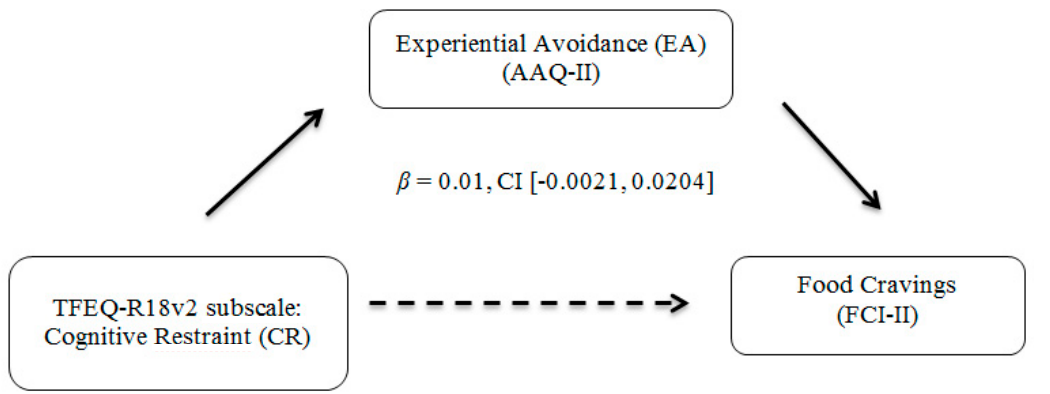
Figure 2. Mediation Analyses Examining EA, food cravings, and Cognitive Restraint among Late Adolescents (Hypothesis 3). Note. Bootstrapping (with 1000 samples) was used in all mediations. 95% confidence intervals (CI) were employed. Mediation was not statistically significant.